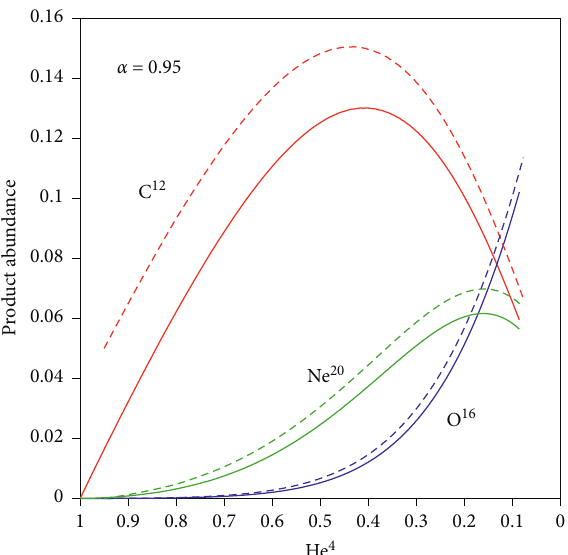
Figure 3: The product abundance (C 12 , O 16 , and Ne 20 ) computed analytically at α � 0 . 95 for the two different abundances. The solid lines represent the helium network with X 0 � 1, Y 0 � 0, Z 0 � 0, and R 0 � 0, and the dashed lines represent the helium network X 0 � 0.95, Y 0 � 0.05, Z 0 � 0, and R 0 �